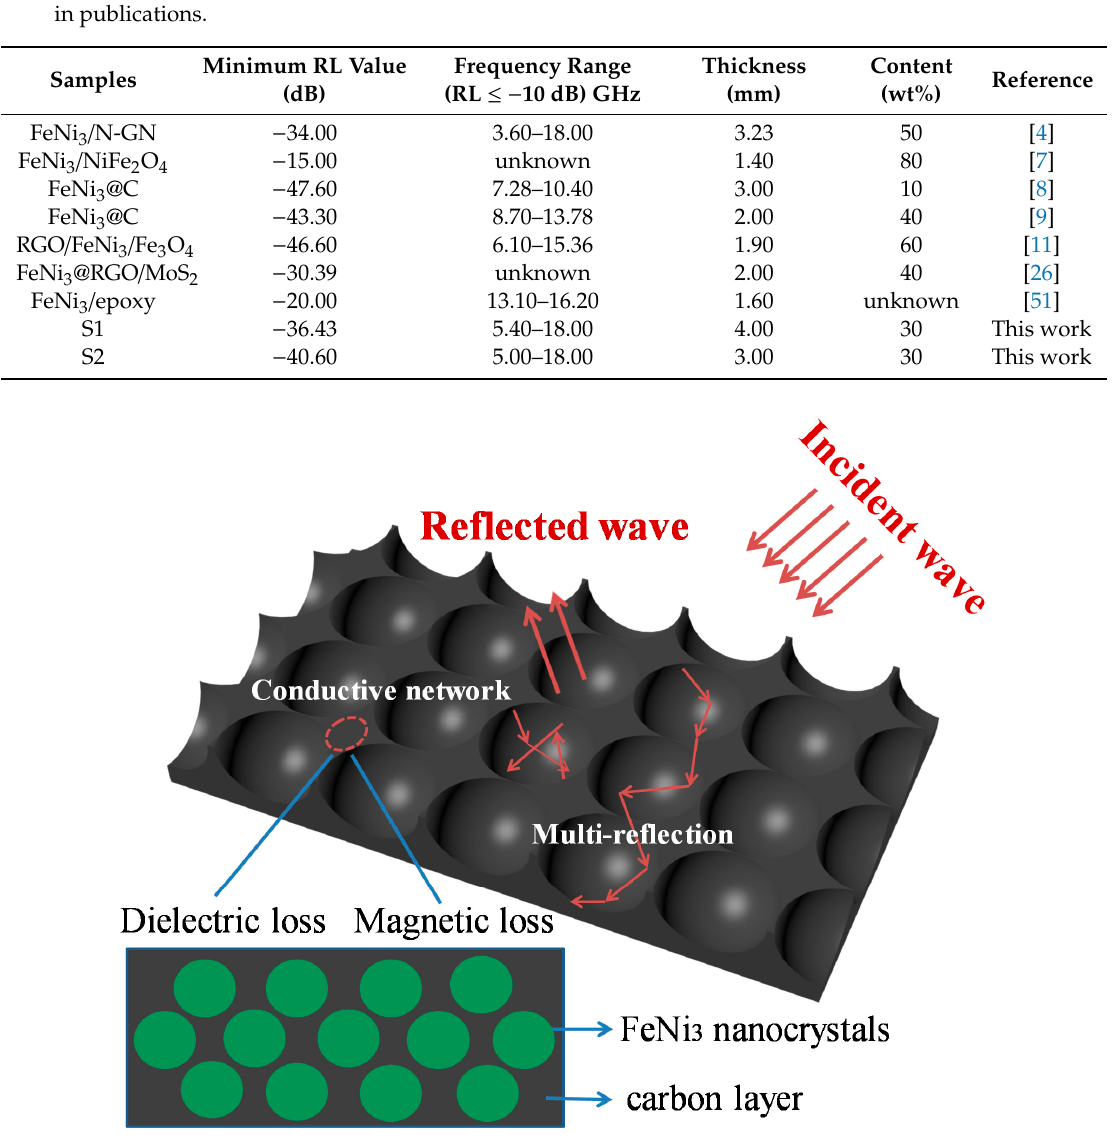
Figure 10. Schematic diagram of microwave absorption for the 3D honeycomb-like FeNi 3 @C.